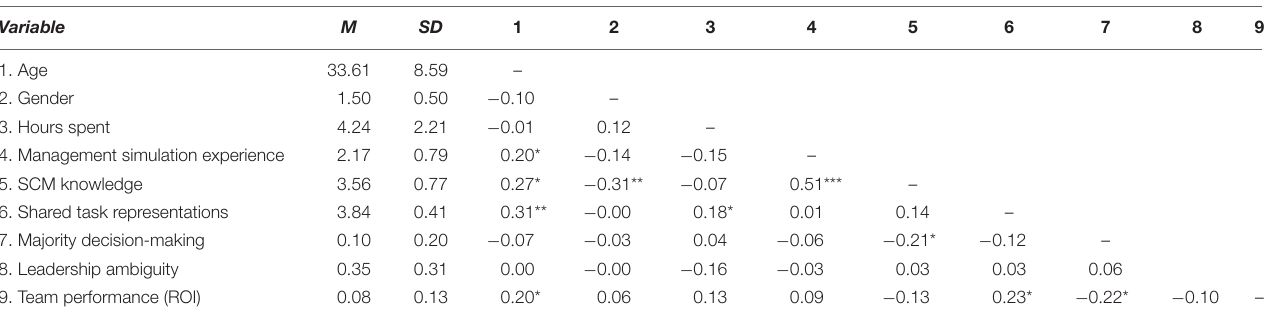
TABLE 1 | Means, Standard Deviations, and Aggregate Level Intercorrelations.